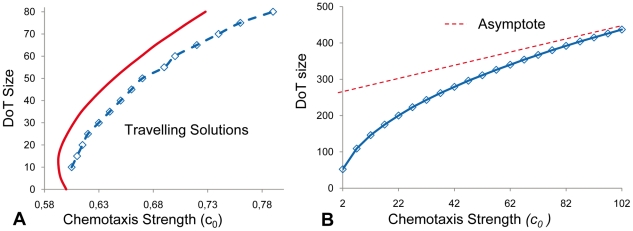
The DoT migration due to chemotaxis in 1D model.The speed of the DoT migration is defined by the formula c = c0(Al−Ar) where Al and Ar are concentrations of protein A on the left and right borders of the DOT. A: The version of the model where the DoT size is fixed (chemotaxis without A-RNA self-repressive production control). The domain in the parameter plane “a versus c0” where the travelling DoT should definitely exist according to the analysis of the model is on the right side of the solid red line (this line represents the border of the domain defined by inequality 16 in the Materials and Methods section. Transition points (between existence and nonexistence) of migrating DoTs in simulations are given by blue markers, dished blue line connecting these markers gives the numerically obtained border. B: The version of the model where the DoT size is controlled by the protein A (chemotaxis with A-mRNA self-repressive production control). The size of the DoT depends on the parameter c0. The difference Al−Ar depends on c0 and saturates when c0→∞ giving a linear asymptotic (red) for the dependence of the DoT size on c0.